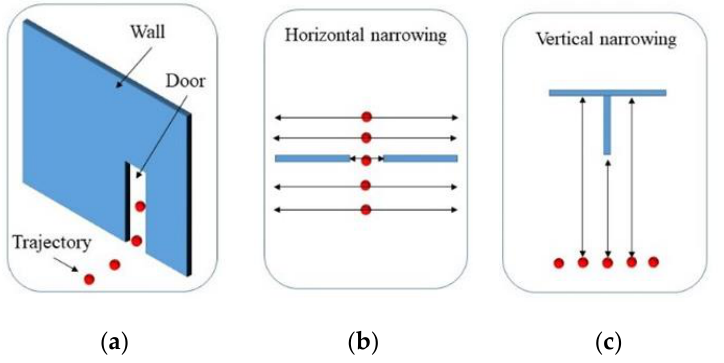
Figure 2. Room segmentation scheme. Red points: Trajectory positions. Blue components: Structural elements. ( a ) General scheme. ( b ) Horizontal spatial narrowing because a door is crossed. ( c ) Vertical spatial narrowing between the trajectory positions and structural components such as ceiling or walls.